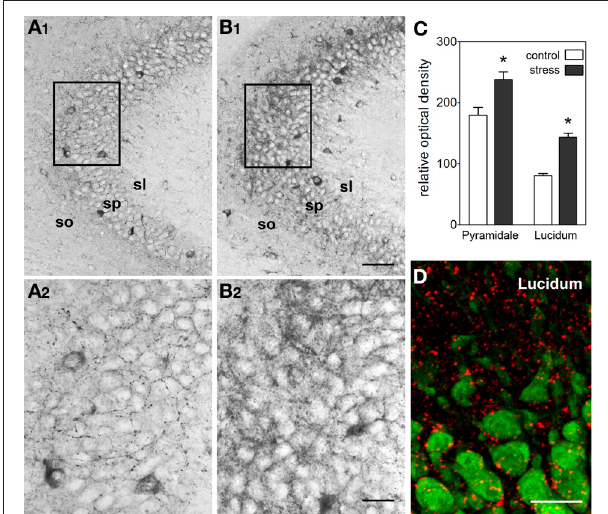
FIGURE 4 | Stress induces rapid release of endogenous CRH into the extracellular space within hippocampus. (A,B) Visualization of stress-induced release of endogenous CRH into the extracellular space (neuropil) in area CA3. Under control conditions (A1,A2) , there is little CRH-immunoreactivity outside of the cell bodies and terminals. In contrast, after a 30-min stress (B1,B2) , immunoreactive peptide is visible within the neuropil of the pyramidal cell layer and adjacent regions. See Chen et al. (2004b) for experimental details. Frames in (A1,B1) denote areas magnified in (A2,B2) , respectively, demonstrating the presence of CRH-immunoreactivity in the extracellular space. (C) Semi-quantitative analysis of CRH-immunoreactivity in presumed extracellular spaces of area CA3 ( n = 5 animals, ∗ P < 0 . 01). (D) Stress-evoked release of endogenous CRH (red) into the extracellular space. NeuN (green) indicates CA3 pyramidal cells. Confocal image from a P18 rat sacrificed after a 30-min stress. Abbreviations: so, stratum oriens; sp, stratum pyramidale; sl, stratum lucidum. Scale bars = 60 μ m in (B1,A1) , 20 μ m in (B2,A2, and D) . Reproduced, with permission, from Chen et al. (2004b) (D)